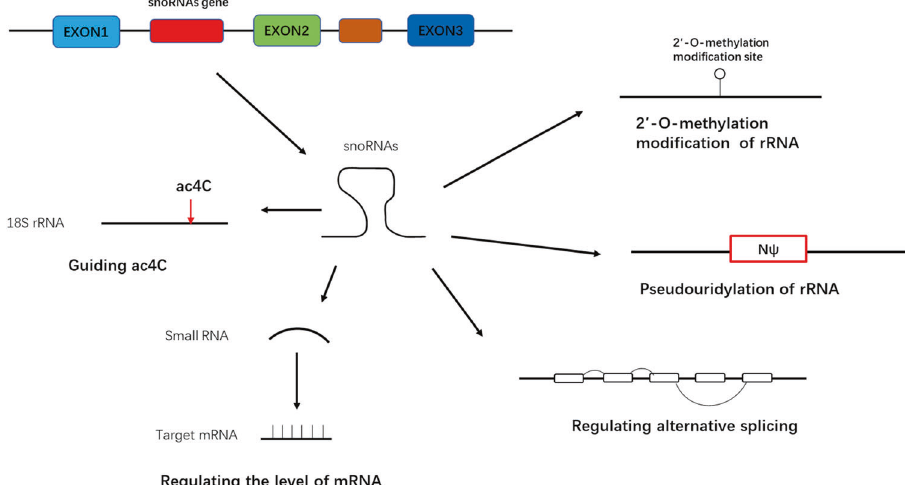
Fig. 3 Molecular mechanisms of snoRNAs in biological processes. The two common mechanisms of snoRNAs contain 2 ′ -O-methylation and pseudouridylation of rRNAs. It is reported that snoRNAs also can regulate alternative splicing, guide N4-acetylcytidine and regulate the level of mRNA like a